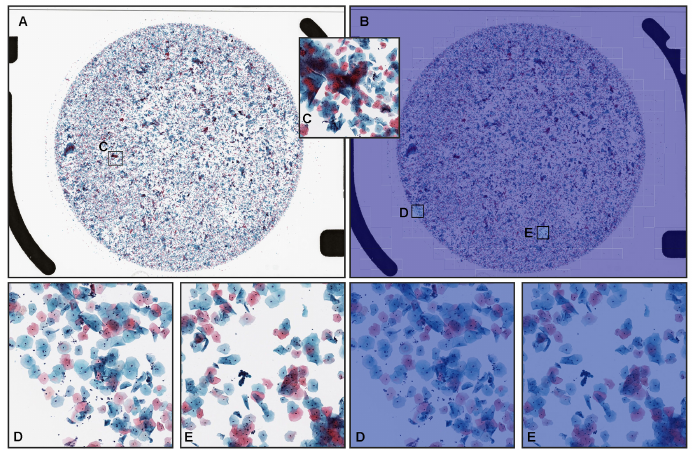
Figure 5. A representative example of neoplastic true negative prediction outputs on a liquid-based cytology (LBC) case from test sets. In the NILM (negative for intraepithelial lesion or malignancy) whole slide image (WSI) of LBC specimen ( A ), the heatmap image ( B ) shows true negative prediction of neoplastic epithelial cells which correspond, respectively, to non-neoplastic epithelial cells ( C ). Moreover, in very low probability tiles ( D , E ) of the same heatmap image ( B ), there are no evidence of neoplastic cells.